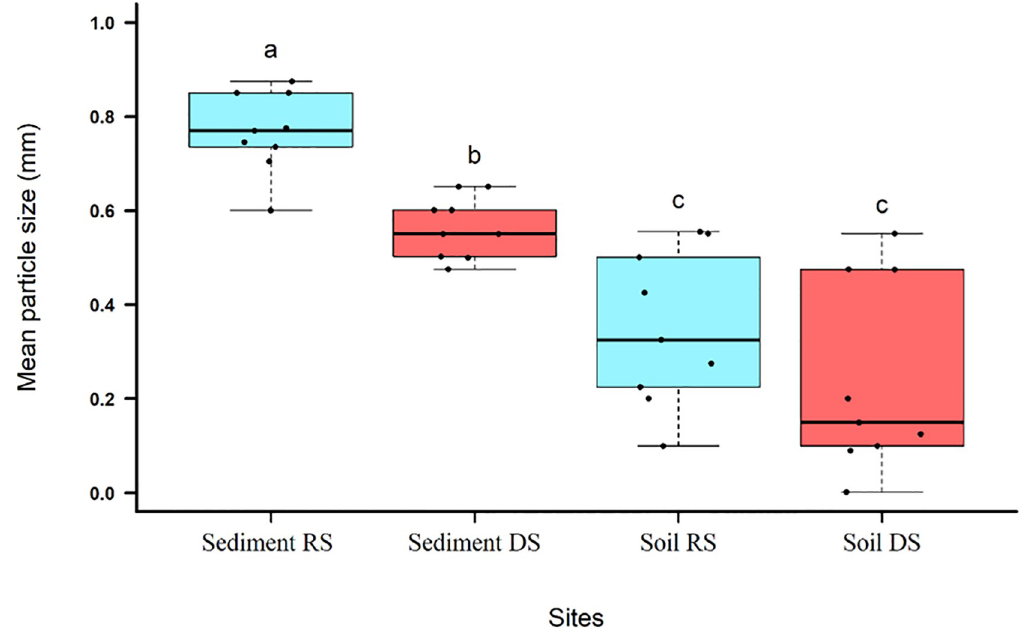
Fig 5. Box-plot type graphics with data from the granulometry of the sediment and soil of the banks of the reference stream (RS) and the degraded stream (DS) in Catal ã o, GO, Brazil. p-value <